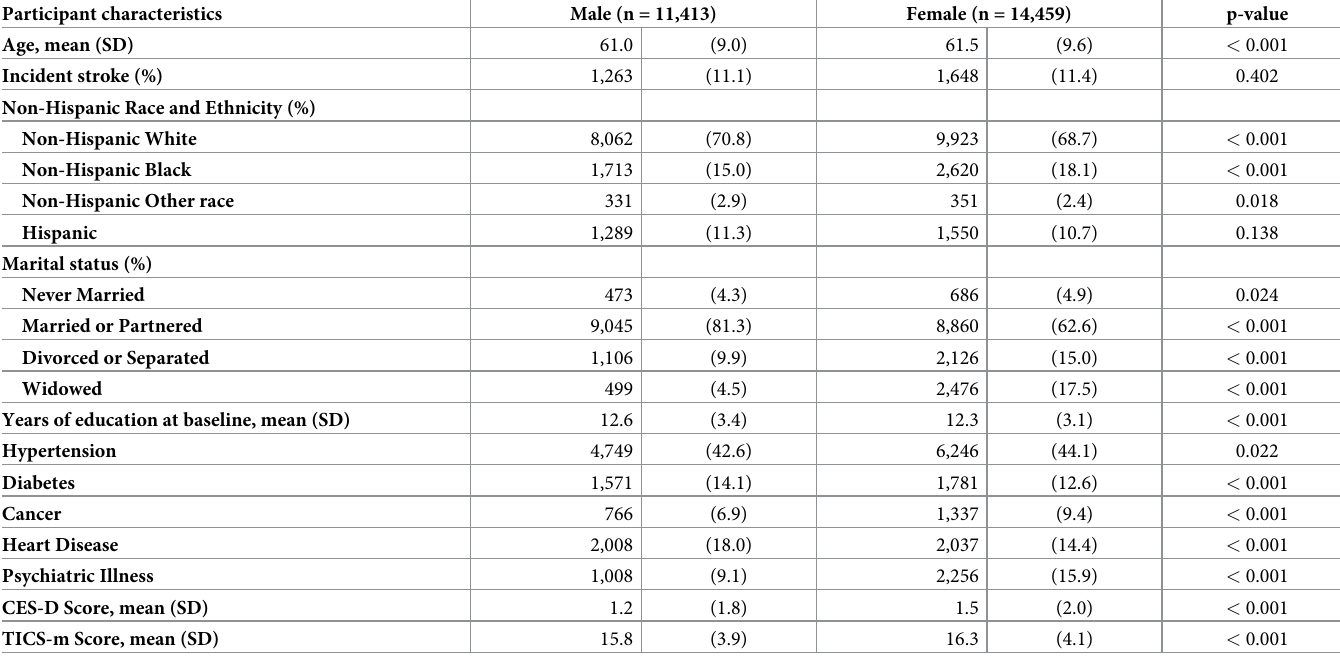
Table 2. Participants’ baseline characteristics by sex.